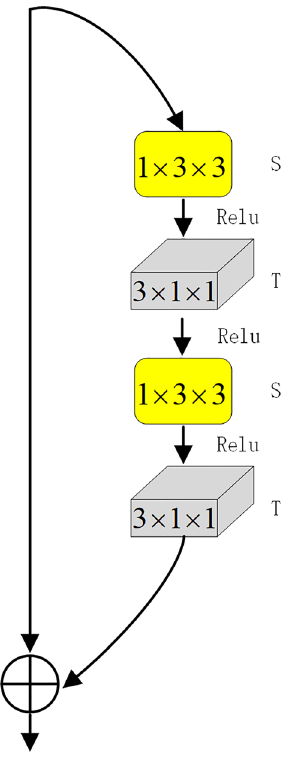
Fig. 2 The R2plus1D